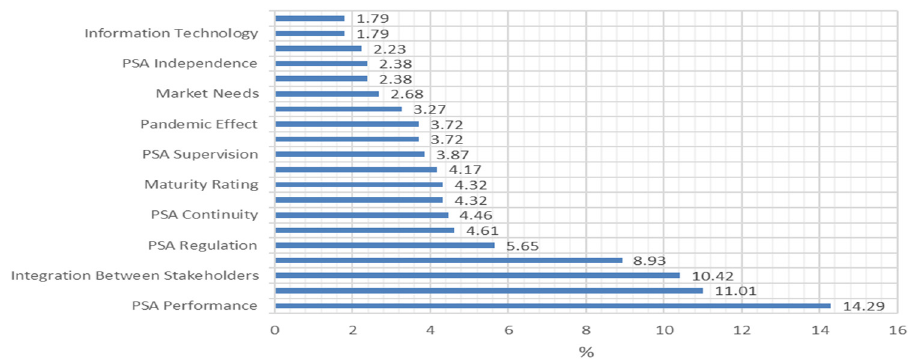
Figure 3. Reference Nodes .